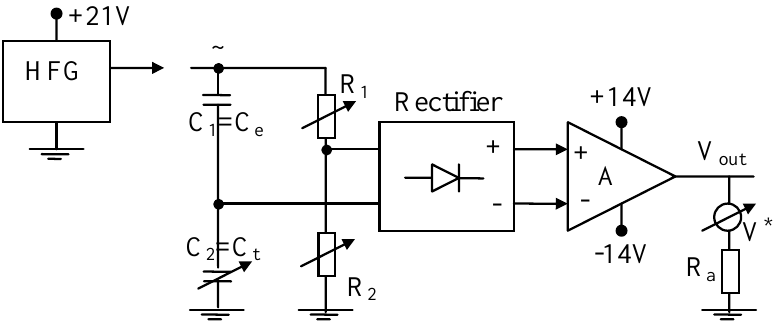
Figure 4. Electronic scheme of the adapter for liquid CO-level transducer.